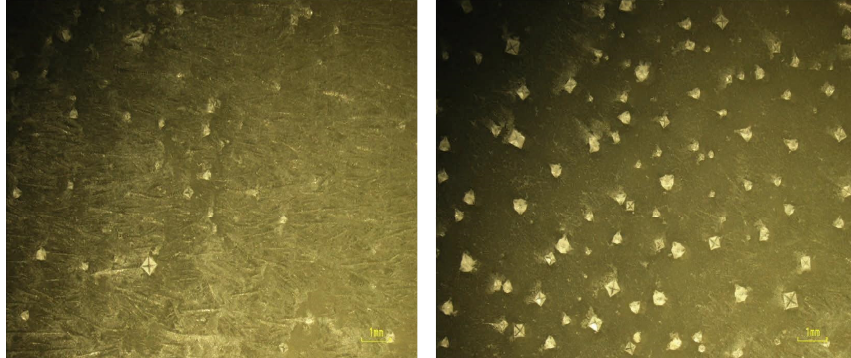
Figure 5: Observation of microplastic particles (respectively) in the sample of incoming wastewater and the sample of efuent discharged from the treatment plant after the separation and acid washing process (disappearance of suspicious particles and their transformation into sediments and appearance of microplastic particles).